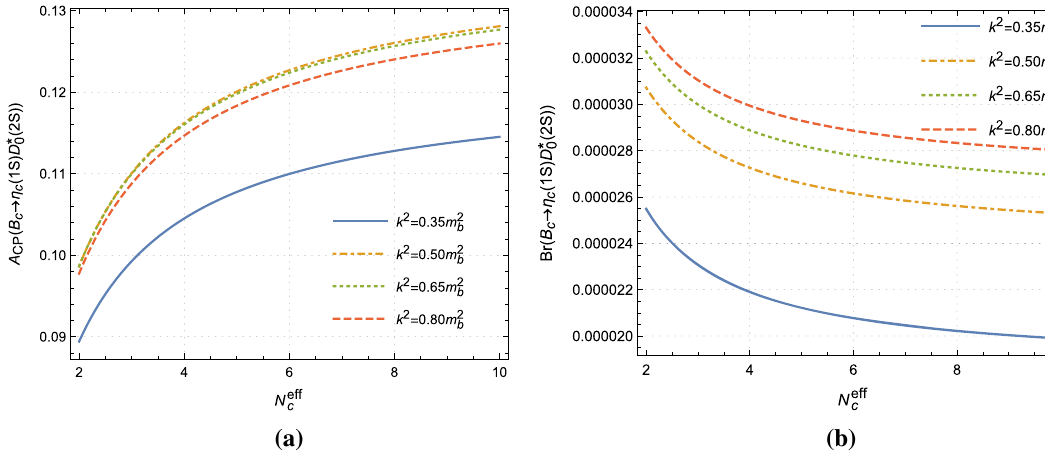
( 1 S ) change with k 2 and N ef f 0